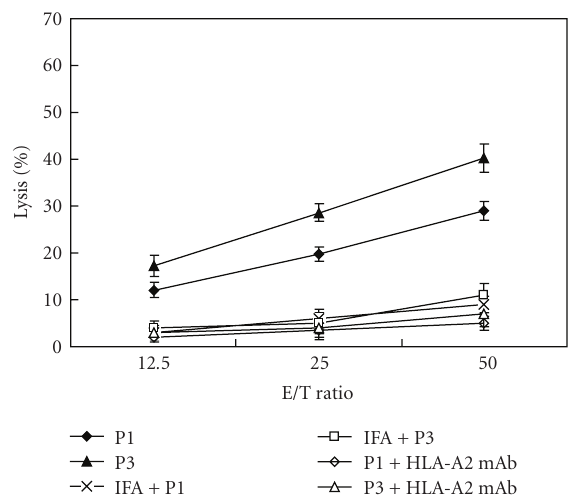
Figure 3: In vivo induction of peptide-specific CTLs. The HLA- A ∗ 0201/K b transgenic mice were immunized with the peptides P1 and P3 prepared in IFA, respectively. Another group of mice were immunized with IFA without peptide as negative control. Mice were sacrificed 10 days after immunization and splenocytes were stimulated in vitro for 5 days with 2 μ g/mL peptide and 10units/mL rmIL-2 to expand them as e ff ector cells. A cytotoxicity assay was used to evaluate the lysis of LB1751-MEL cells by peptide- stimulated splenocytes from corresponding peptide-immunized mice (P1 and P3), P1- or P3-stimulated splenocytes from IFA- immunized mice (IFA+P1 and IFA+P3), and the lysis of LB1751- MEL cells, which surface HLA-A ∗ 0201 molecules were blocked with ant-HLA-A ∗ 0201 mAb, by peptide-immunized mice (P1 + HLA-A2 mAb and P3 + HLA-A2 mAb). The experiment was repeated three